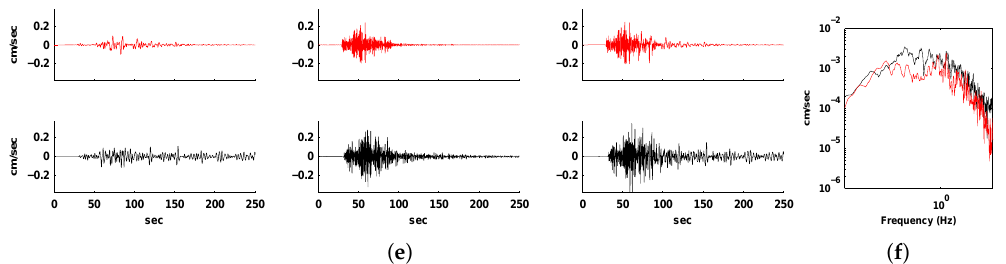
Figure 16. ( a ) North-south component, ( c ) east-west component, and ( e ) vertical component of ground velocity histories at Station 40. Shown in red are the long-period spectral-element-simulated (column 1), high-frequency EGF-synthesized (column 2), and combined broadband histories (column 3) for the 2004 Parkfield earthquake. Shown in black are the corresponding filtered observed ground velocity records for comparison. ( b , d , f ) show the comparison of the corresponding spectra of the broadband velocity histories (red: synthesized, black: observed).